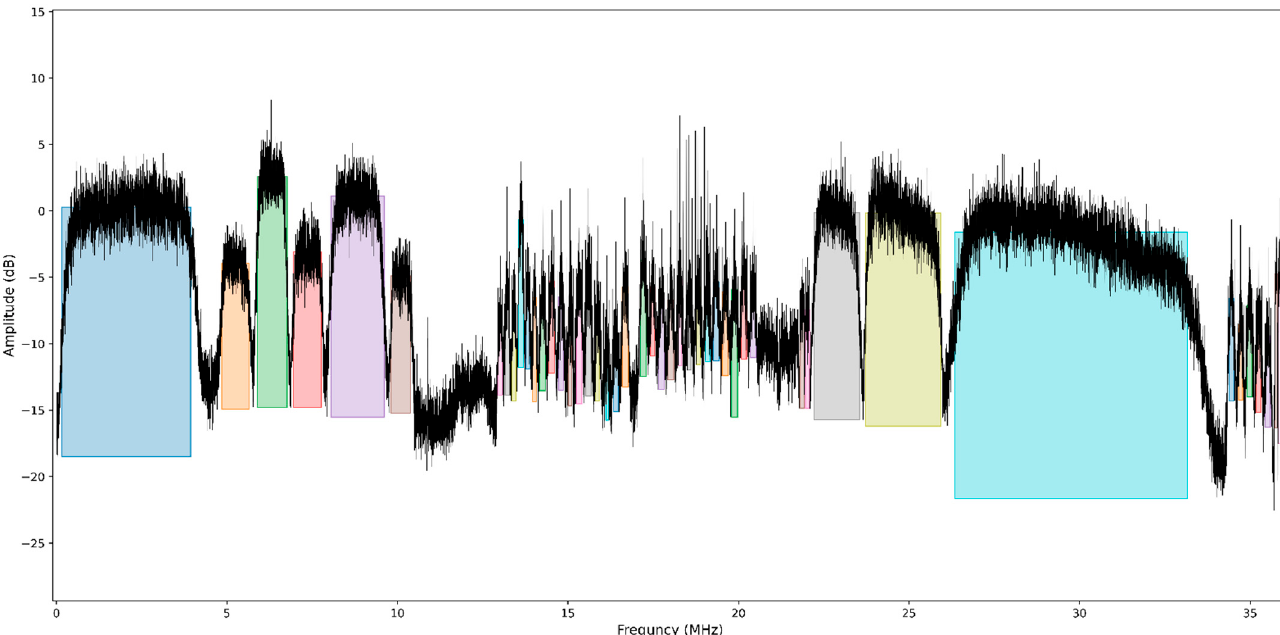
Figure A4. Example4 of the actual satellite broadband power spectrum set.